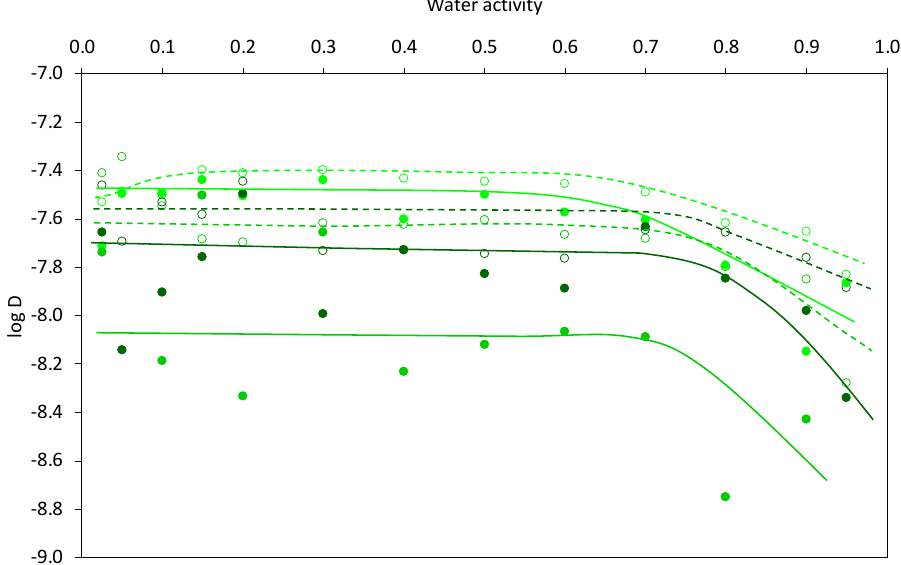
Figure 12. Water vapor diffusion coefficients D 1 and D 2 for the PLA/PBSA, PLA/PBSA2 and PLA/PBSA5 multilayer films.